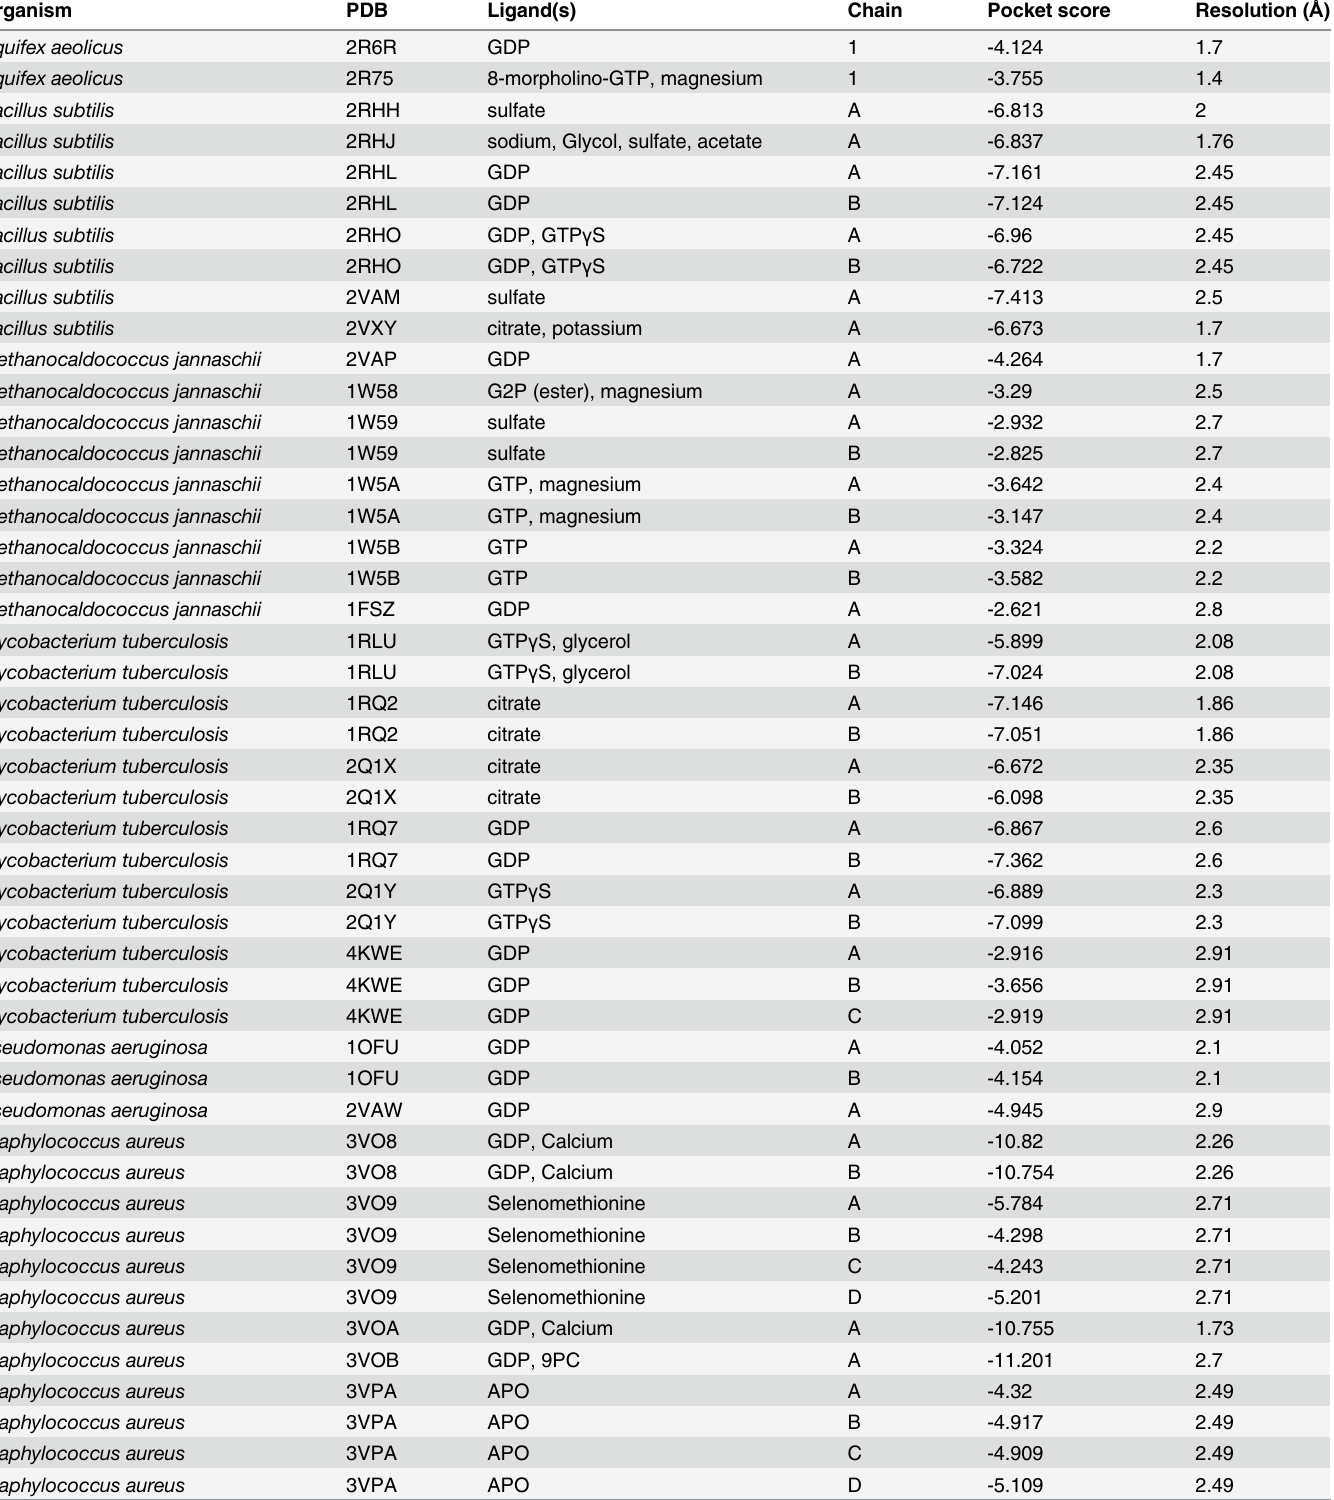
Table 1. Description of FtsZ crystal structures for which PocketFEATURE scores were